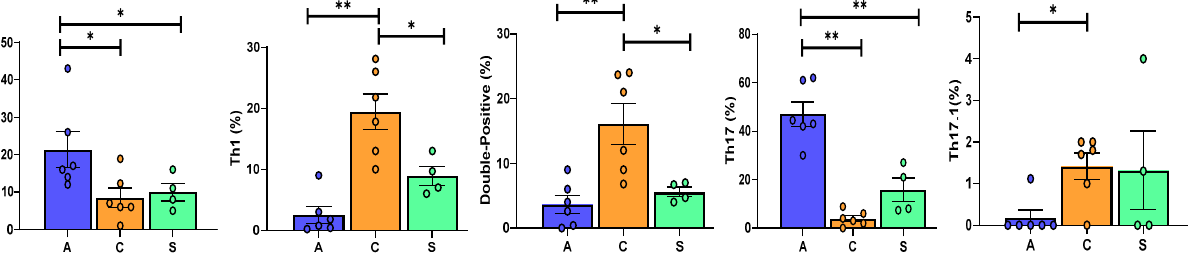
Figure 7. Data represent individual values on BAL, mean (center bar) ± SEM (upper and lower bars). If not indicated, p Fig. 7. Data represent individual values on BAL. mean (centre bar) ± SEM (upper and lower bars). If not indicated. p value is not significant. value is not significant. * p < 0.05, ** p < 0.01. Abbreviations: A: acute, C: chronic, S: *p<0.05. **p<0.01. ***p<0.001.